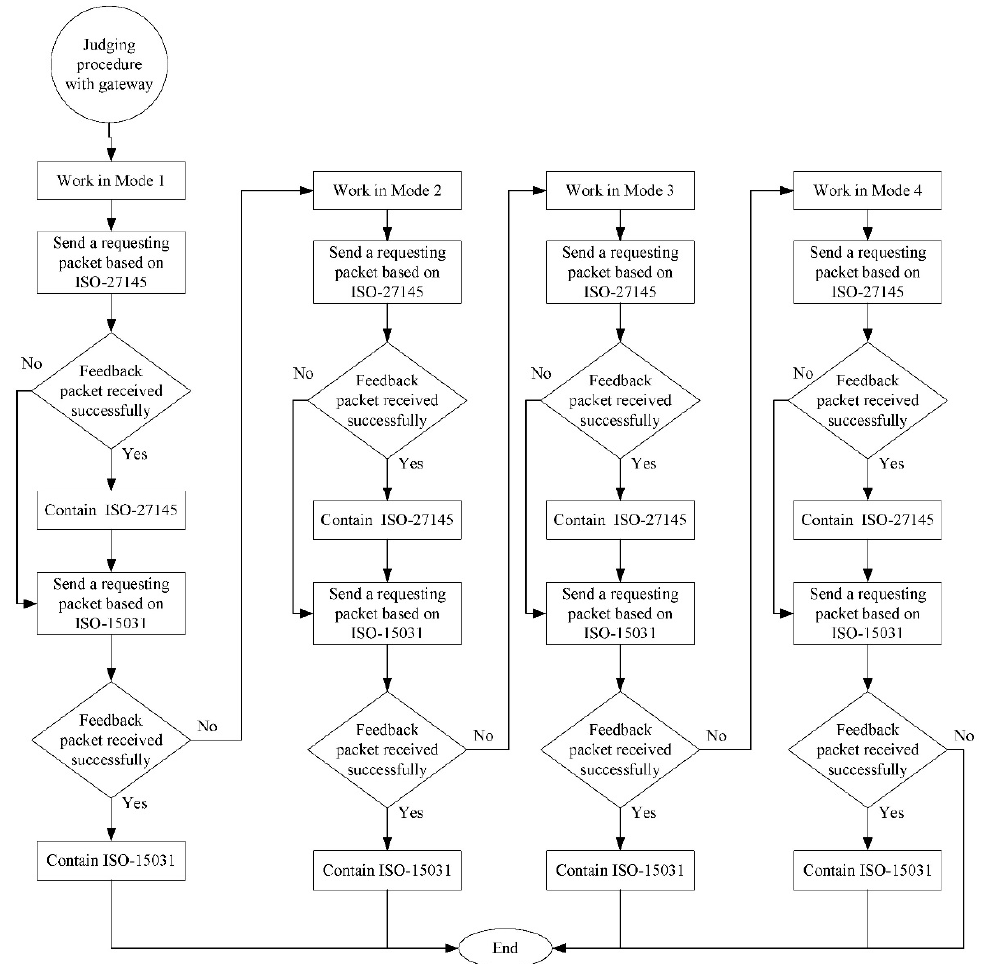
Figure 5. CAN bus communication protocol identification with gateways.